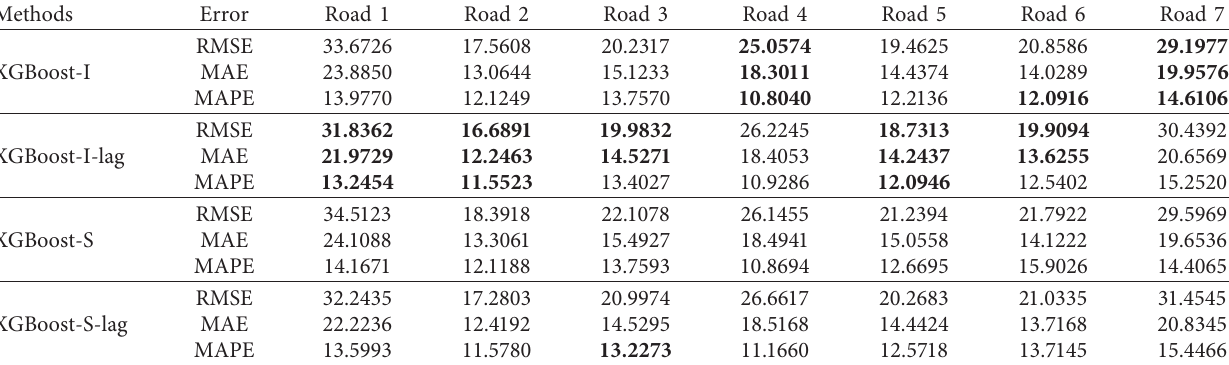
Figure 8: Spatial lag of up-direction and down-direction. Table 4: Up-direction-related XGBoost models’ prediction results.